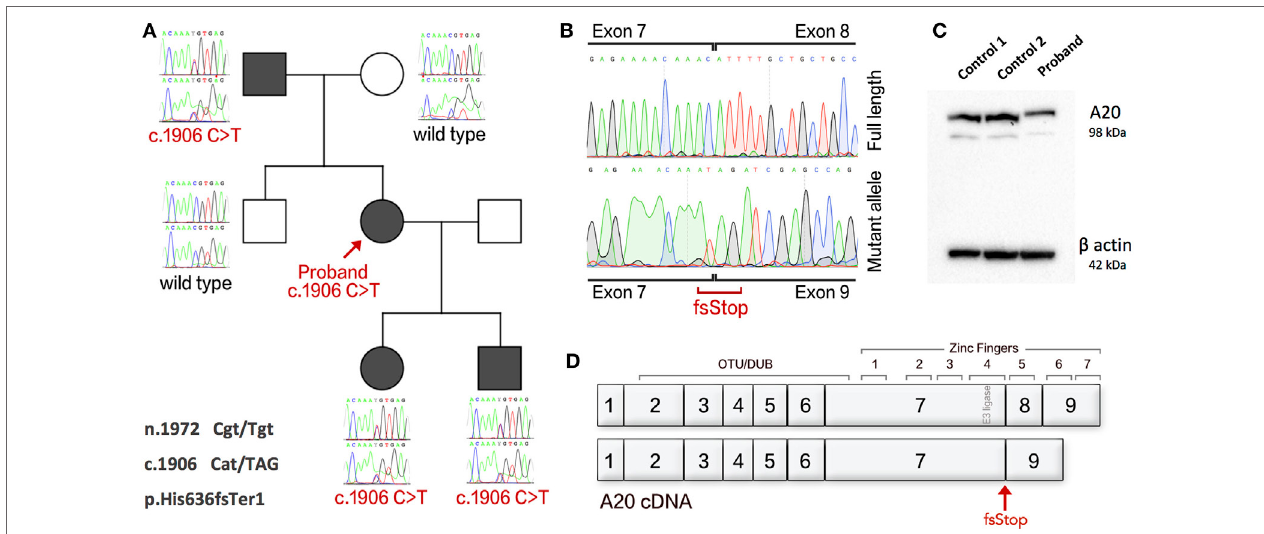
FIGURe 1 | An exonic splice variant in TNFAIP3 results in deletion of exon 8 in cDNA and A20 haploinsufficiency. (a) The Sanger sequences of gDNA in family members showing disease segregation. (B) cDNA of proband with separated wild-type and splice variant alleles showing deletion of exon 8. (C) Western blot analysis of proband and two healthy controls showing HA20. (D) Gene structure of A20 cDNA showing functional domains and the resulting splice variant. Protein purified from PBMCs using sodium orthanovanadate, Complete Protease Inhibitor Cocktail and PMSF (Sigma), with RIPA buffer. Western blotting used an antibody to A20/TNFAIP3 (D13H3) (N-term) Rabbit mAb 5630S (Cell Signaling Technology). The Novex Mini Gel Tank and blot module, Bolt 4–12% Bis–Tris Plus Gels, and PVDF Transfer Membrane (Thermo Fisher Scientific). Imaging used Super Signal West Femto/Pico (Thermo Fisher Scientific).